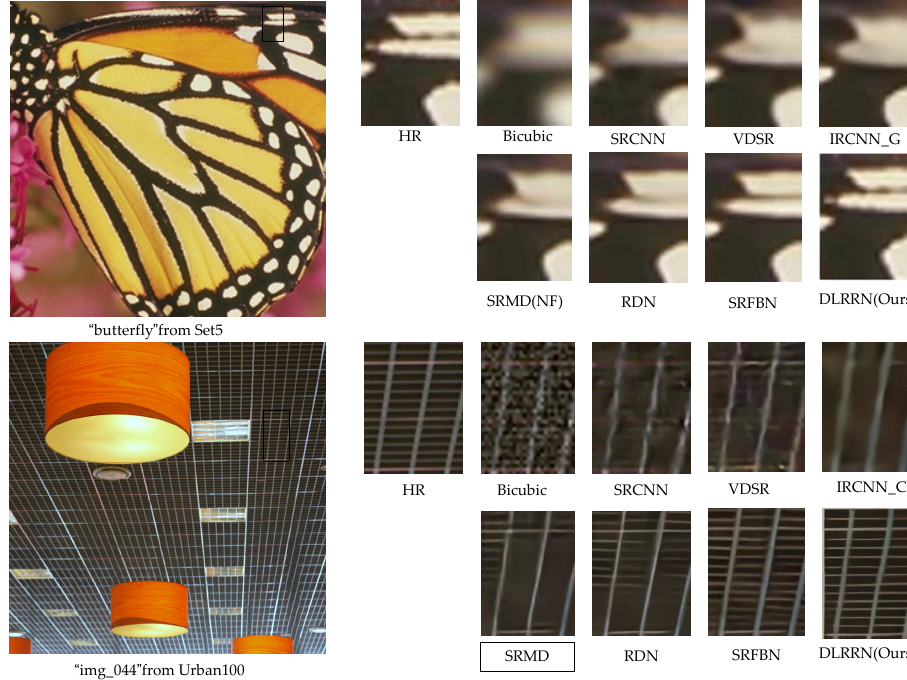
Figure 12. The visualization results of BD × 3 and DN × 3; the first group and the second group represent the results of BD × 3 and DN × 3, respectively.